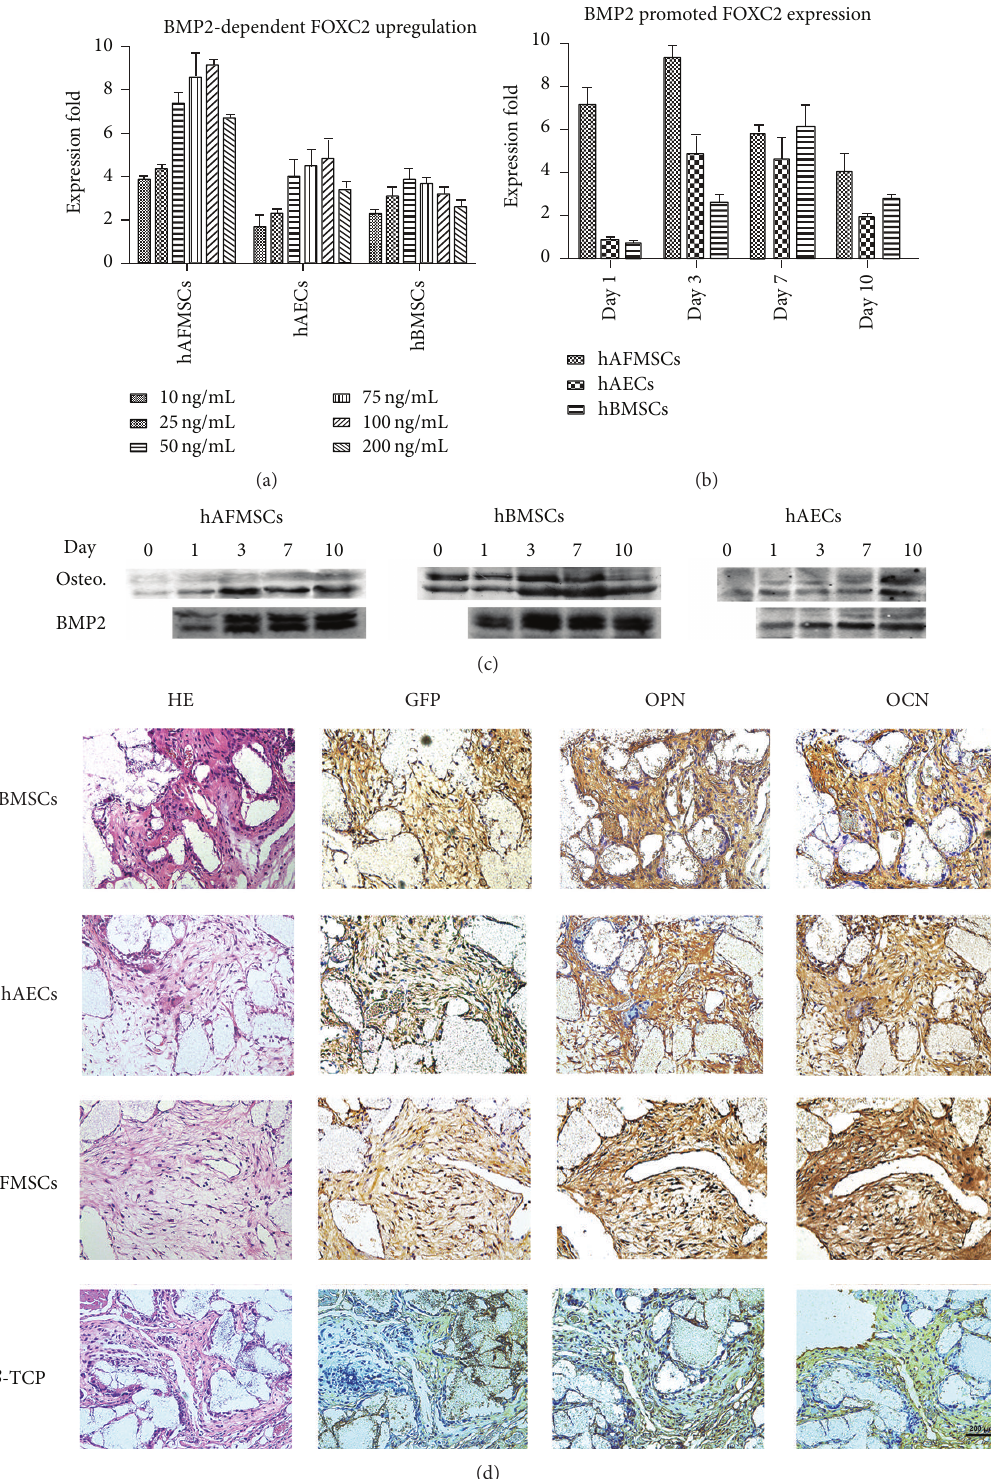
Figure 4: Verification of the upregulation of FOXC2 and ectopic osteogenesis of hAECs, hBMSCs, and hAFMSCs. (a) Expression of FOXC2 inallthreecelltypeswassignificantlyincreasedinaBMP2-dependentmanner.(b,c)Bothreal-timePCRandwesternblotrevealedthatBMP2 significantly promoted the expression of FOXC2 in all the three cell sources. The western blot study also demonstrated that undifferentiated hBMSCs exhibited a higher expression level of FOXC2 than the other two cell sources. (d) Ectopic osteogenesis of hAECs, hBMSCs, and hAFMSCs in nude mice. 𝛽 -TCP scaffolds carrying hAECs, hAFMSCs, and hBMSCs or alone were implanted subcutaneously for 4 weeks. HE staining showed no well-mineralized islands in either experimental groups or control group. Immunohistochemical staining showed that all cell types were viable as indicated by the positive expression of GFP. Moreover, OPN and OCN were evident in the experimental groups but not in the control